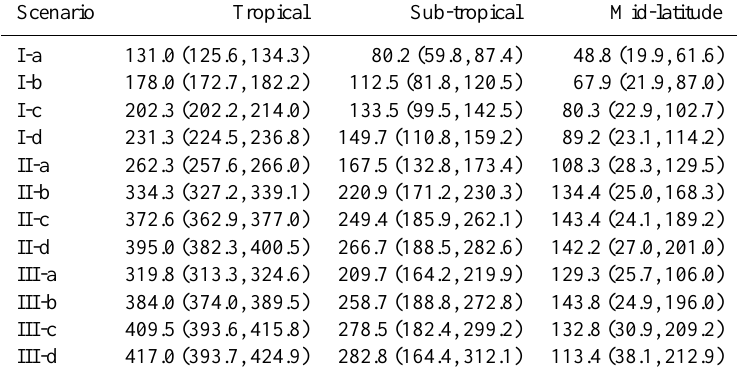
Table 4. Maximum enhanced HCHO mixing ratios ( 1 [HCHO] max ) inside the ship plumes from the scenario simulations